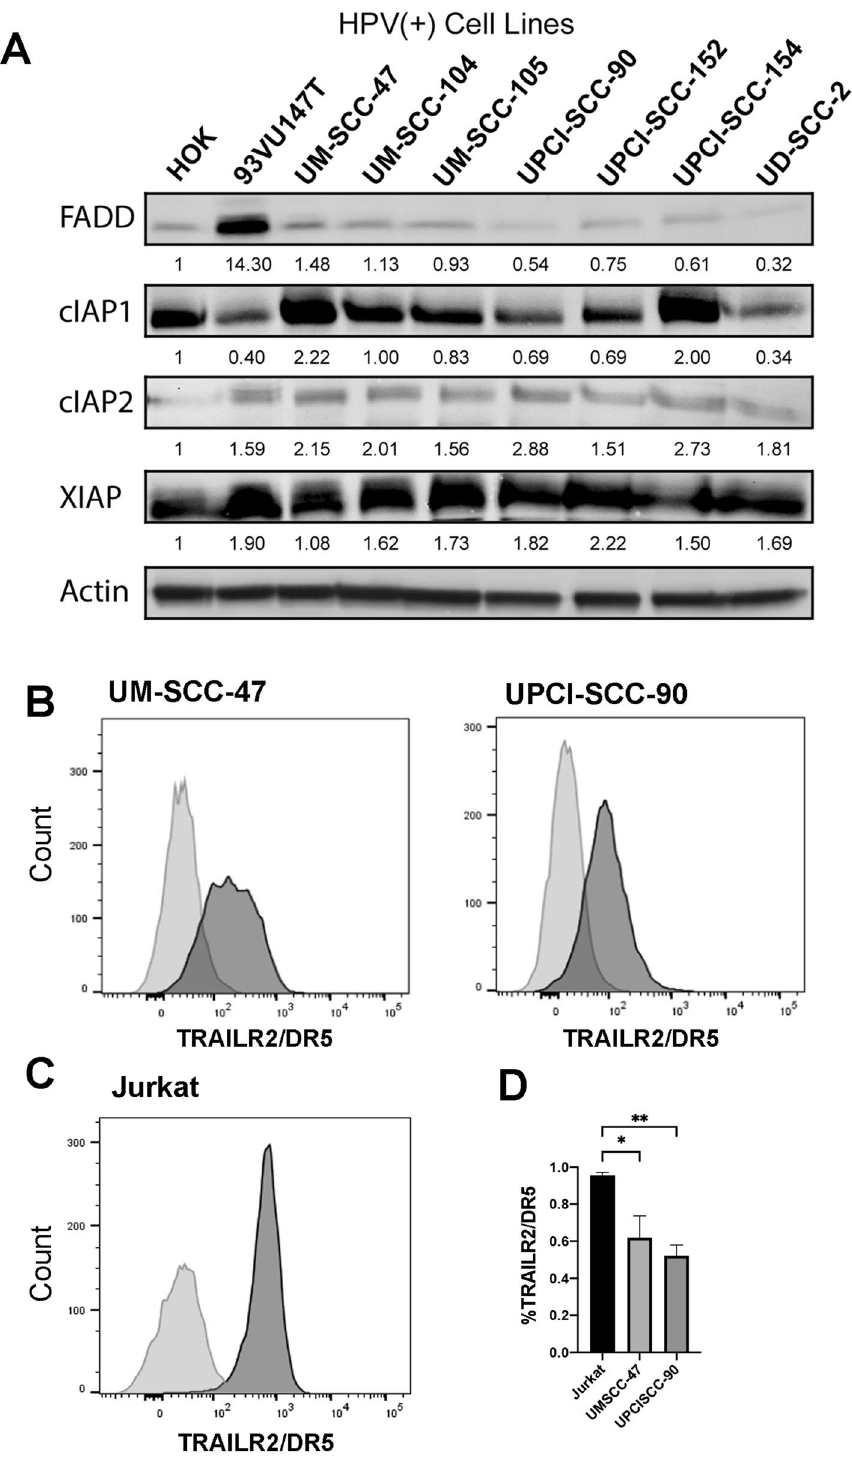
Figure 3. Protein expression of FADD, IAPs, and TRAILR2/DR5 in HPV(+) HNSCC cell lines. ( A ). Protein expression from whole cell lysates of HOK and a panel of HPV(+) HNSCC cell lines were examined by Western blot. Protein expression was quantified by comparison to HOK and actin as a loading control. ( B ) UM-SCC-47 and UPCI-SCC-90 cells were stained with fluorescent conjugated anti-TRAILR2/DR5 antibody and Zombie-violet for viability. The x-axis represents TRAILR2/DR5 fluorescent intensity, and the y-axis represents cell count. Percentages of TRAILR2/DR5 positivity among live cells for each cell line are represented and compared with the negative controls of unstained cells. ( C ) TRAILR2/DR5 staining of Jurkat cells was served as a positive control for data presented by ( B ), and the unstained cells served as the negative control. ( D ) There was no statistical difference in the percentages of TRAILR2/DR5 positive staining cells between the two HNSCC cell lines. The data are presented by six replicates from two independent experiments. * or ** indicates Student’s t test, p < 0.05 or